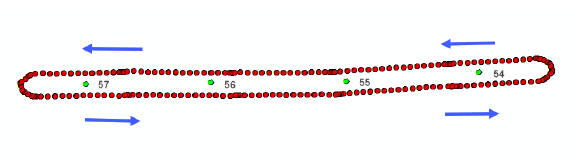
Figure 3. Dual-strip flight mode for data acquisition. Red circles are image positions. Green circles are locations of power pylons. Blue arrows stand for UAV flying